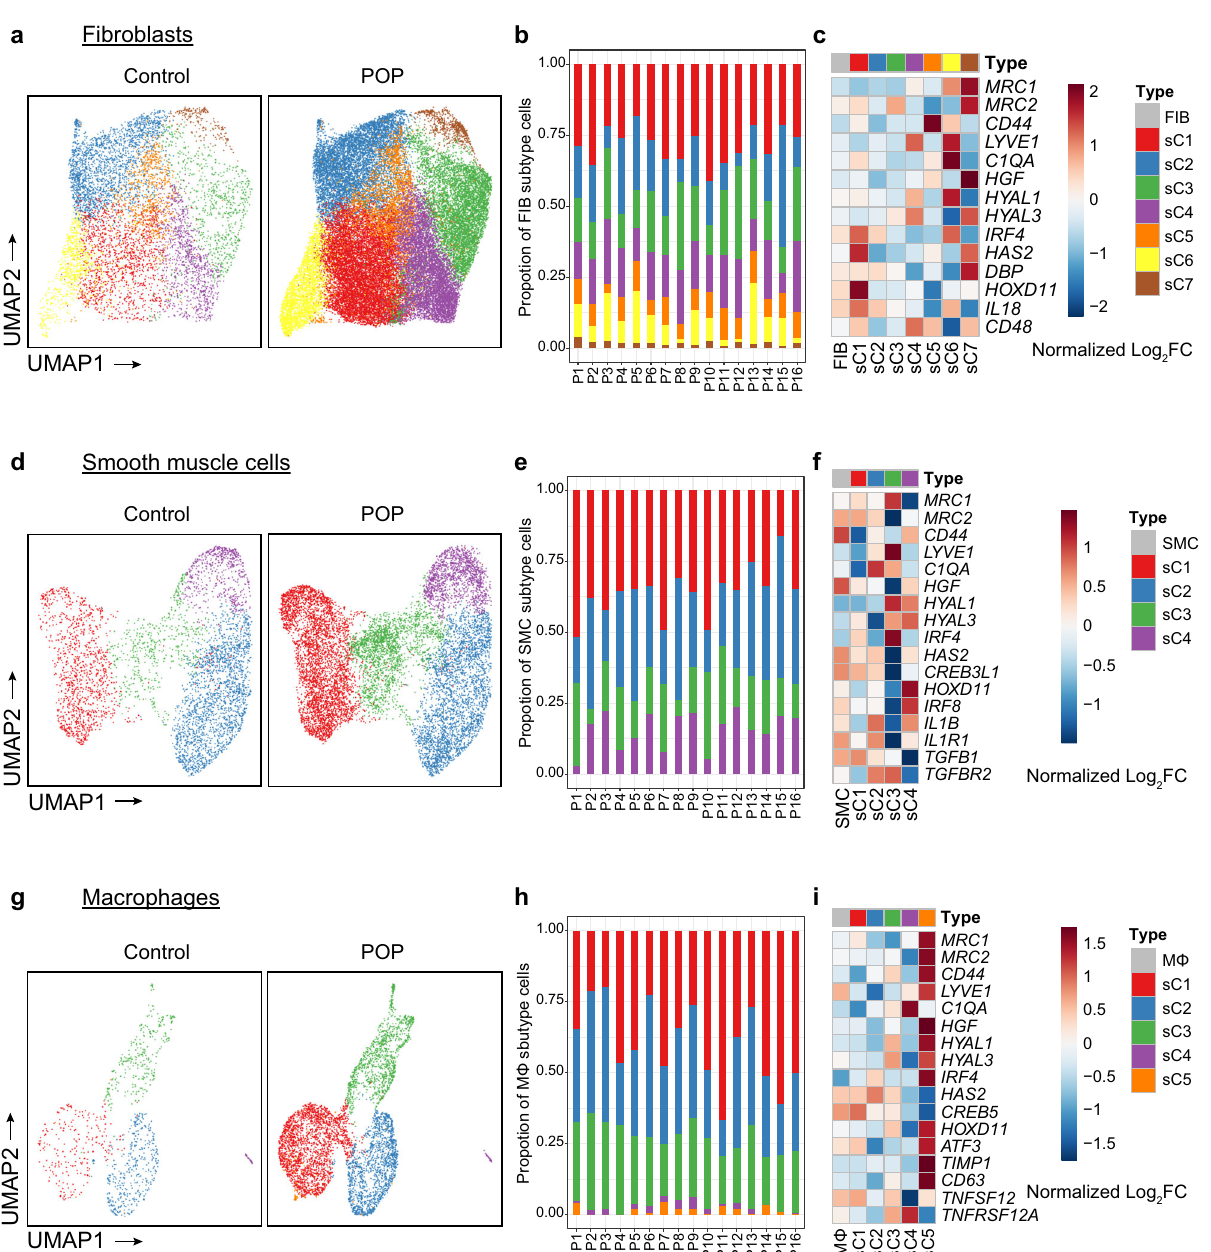
Fig. 5 Subclustering of major cell types in the vaginal wall reveals cellular heterogeneity. a UMAP plot showing the distribution of seven distinct fi broblasts subtypes in control and POP samples. b Bar plots showing the percentage of seven fi broblast subtypes in each POP patient ( n = 16 patients). c Relative expression of representative DEGs, TFs and ligand – receptor pairs among seven subtypes in POP samples than that in control samples. d Subclustering of smooth muscle cells further identi fi ed four distinct subtypes. e Bar plots showing the percentage of four smooth muscle cells subtypes in each POP patient ( n = 16 patients). f Relative expression of representative DEGs, TFs and ligand – receptor pairs among four subtypes in POP samples than that in control samples. g Subclustering of macrophages further identi fi ed fi ve distinct subtypes. h Bar plots showing the percentage of fi ve macrophages subtypes in each POP patient ( n = 16 patients). i Relative expression of representative DEGs, TFs and ligand – receptor pairs among fi ve subtypes in POP samples than that in control samples. P,